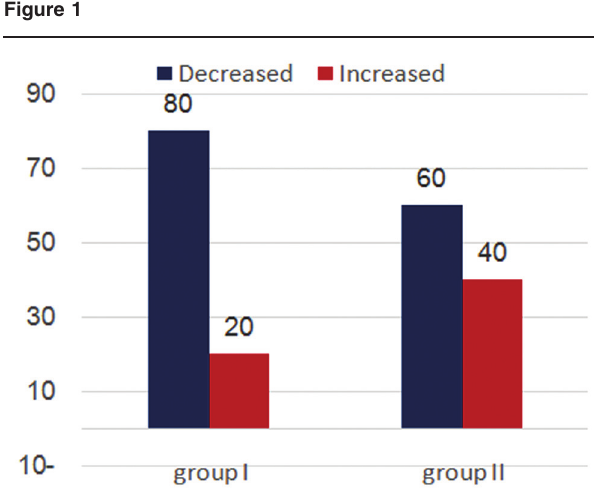
The difference between groups as regards change in the amount of secretion on day 5 of aerosolized antibiotics